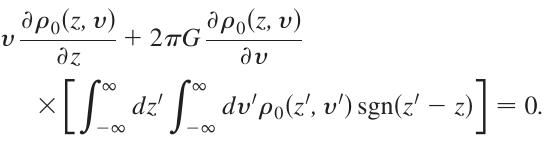
FIG. 7. (Color) Simulation result of the 2D rotating galaxy: (a) initial distribution of 500 stars in the x - y space; (b) final distribution after 1000 = 2 (cid:2) periods; (c) plot of galaxy emittance p ffiffiffiffiffiffiffiffiffiffiffiffiffiffiffiffiffiffiffiffiffiffiffiffiffiffiffiffiffiffiffiffiffiffiffiffiffiffiffiffiffiffiffiffiffiffiffiffiffi A Þ 2 (cid:4) = 2 þ ð x=A Þ 2 (cid:5) ¼ ½ð _ x=! as a function of the step number 0 t= (cid:1) t , showing no sign of